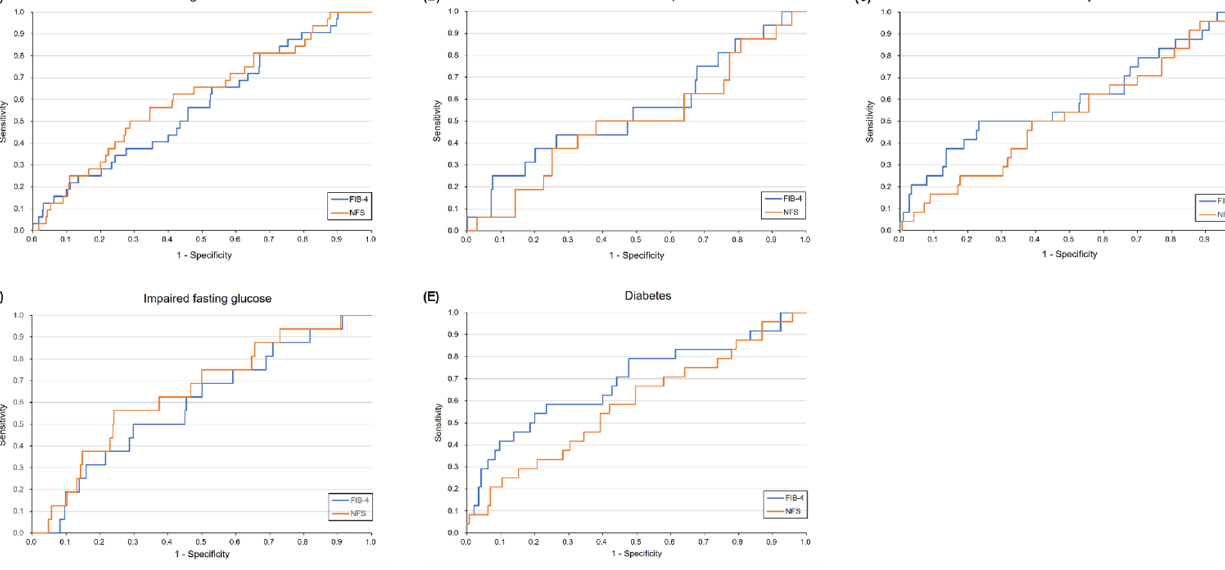
Figure 3. Diagnostic performance of FIB-4 index and NFS for diagnosis of significant fibrosis in five conditions. ( A ) USG-diagnosed NAFLD; ( B ) Elevated liver enzyme; ( C ) Metabolic syndrome; ( D ) Impaired fasting glucose; ( E ) Diabetes.